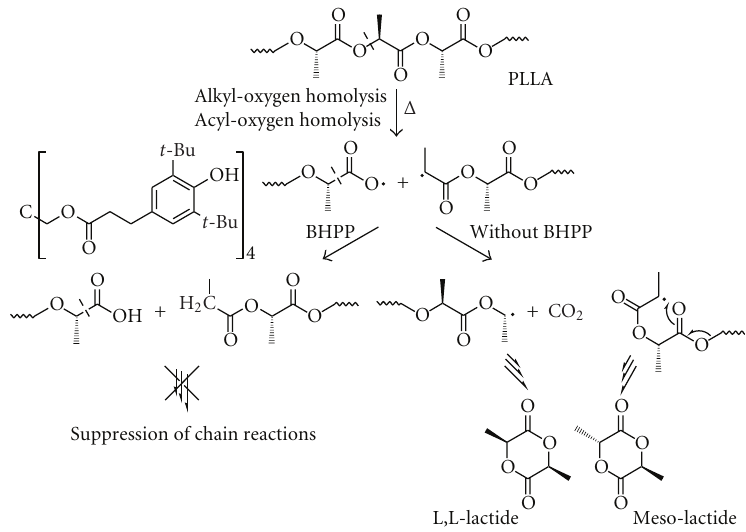
Scheme 1: Expected inhibitive mechanism on PLLA homolysis by BHPP.